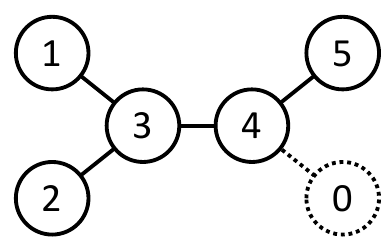
Figure 5 . Dynkin diagram of the D 5 algebra. The number in circles corresponds to the subscript of the generators of the Weyl symmetry (2.35). Solid circles and lines denote the Dynkin diagram of the ordinary D 5 algebra, while the dashed one is for the lowest element s 0 which is generated by the other generators